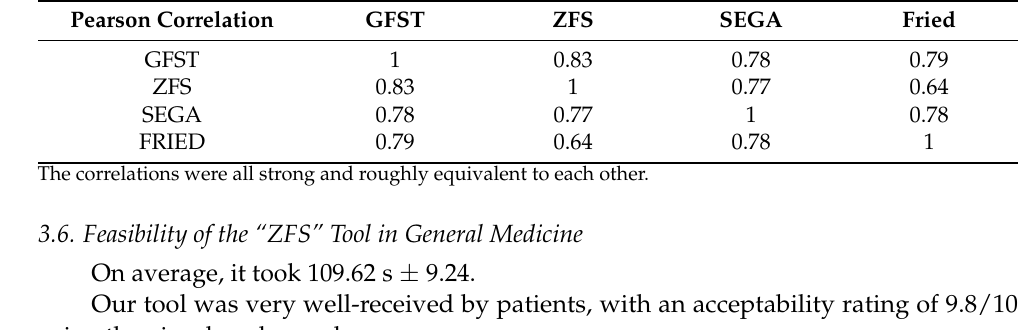
Table 13. Frailty geriatric score correlation. Pearson